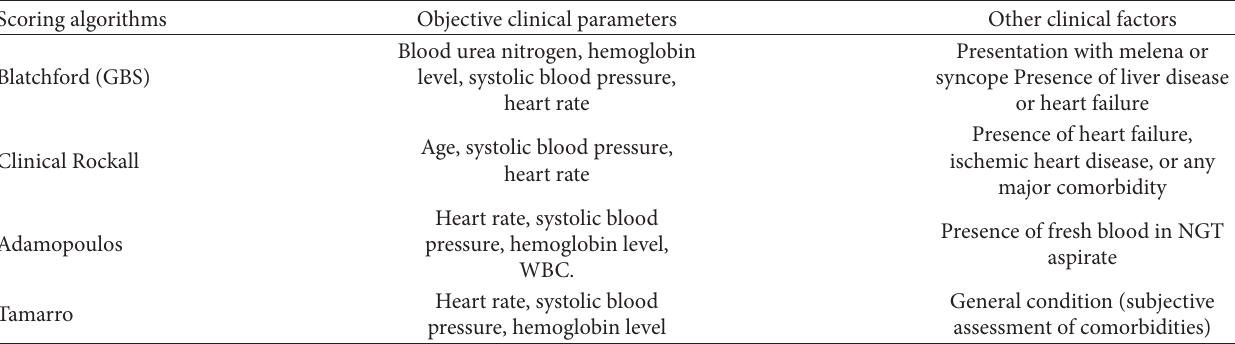
Table 1: Clinical parameters used in scoring